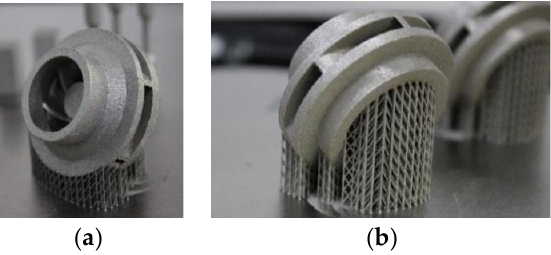
Figure 5. Closed impellers built at B + 60° orientation: ( a ) front view; ( b ) the back view of closed impeller.